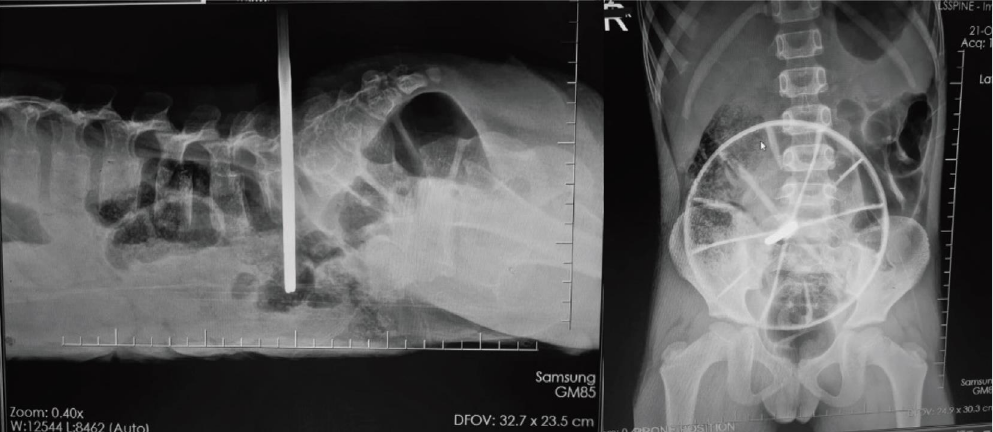
Figure 2: Radiographic imaging of the patient shows a radiopaque metallic rod and wheel seen at the right hemiabdomen immediately lateral to the L5 vertebrae with no apparent bone involvement at the time of the exam.